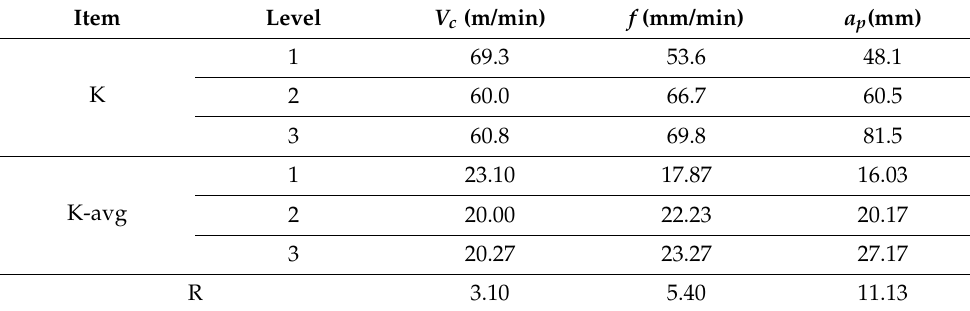
Table 11. Range analysis of the normal milling force F n